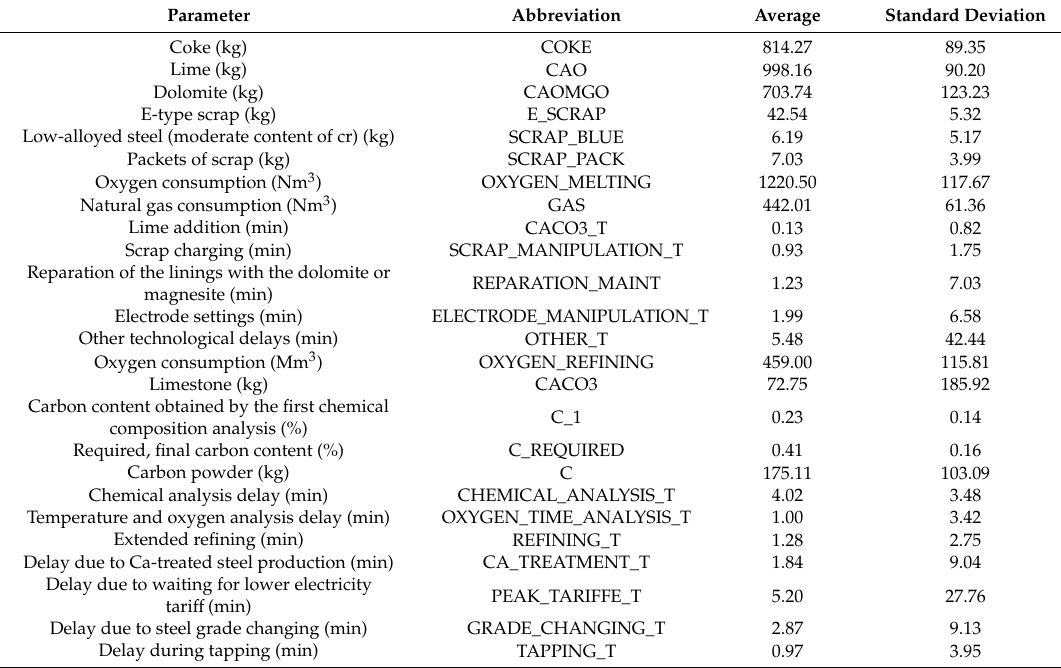
Table 1. The average values and the standard deviation of the individual parameters from 3248 consecutively produced batches at the Štore Steel company in